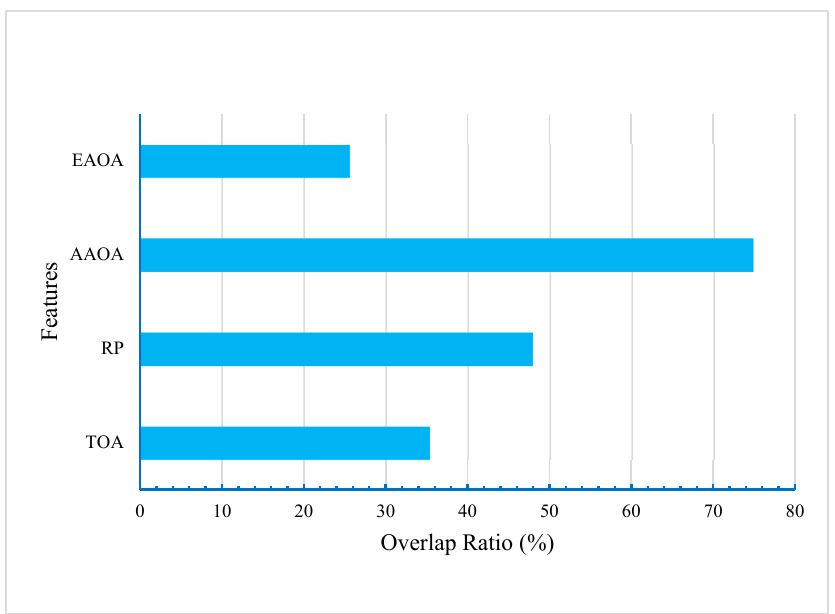
Figure 7. PDF of di ff erent extracted characteristics: ( a ) Received power, ( b ) TOA, ( c ) AAOA, and ( d ) EAOA.